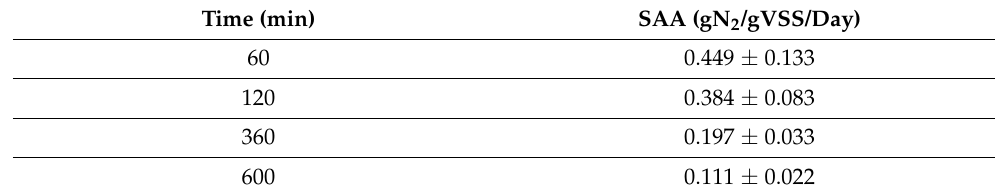
Table 1. Changes in the rSAA value over the reaction